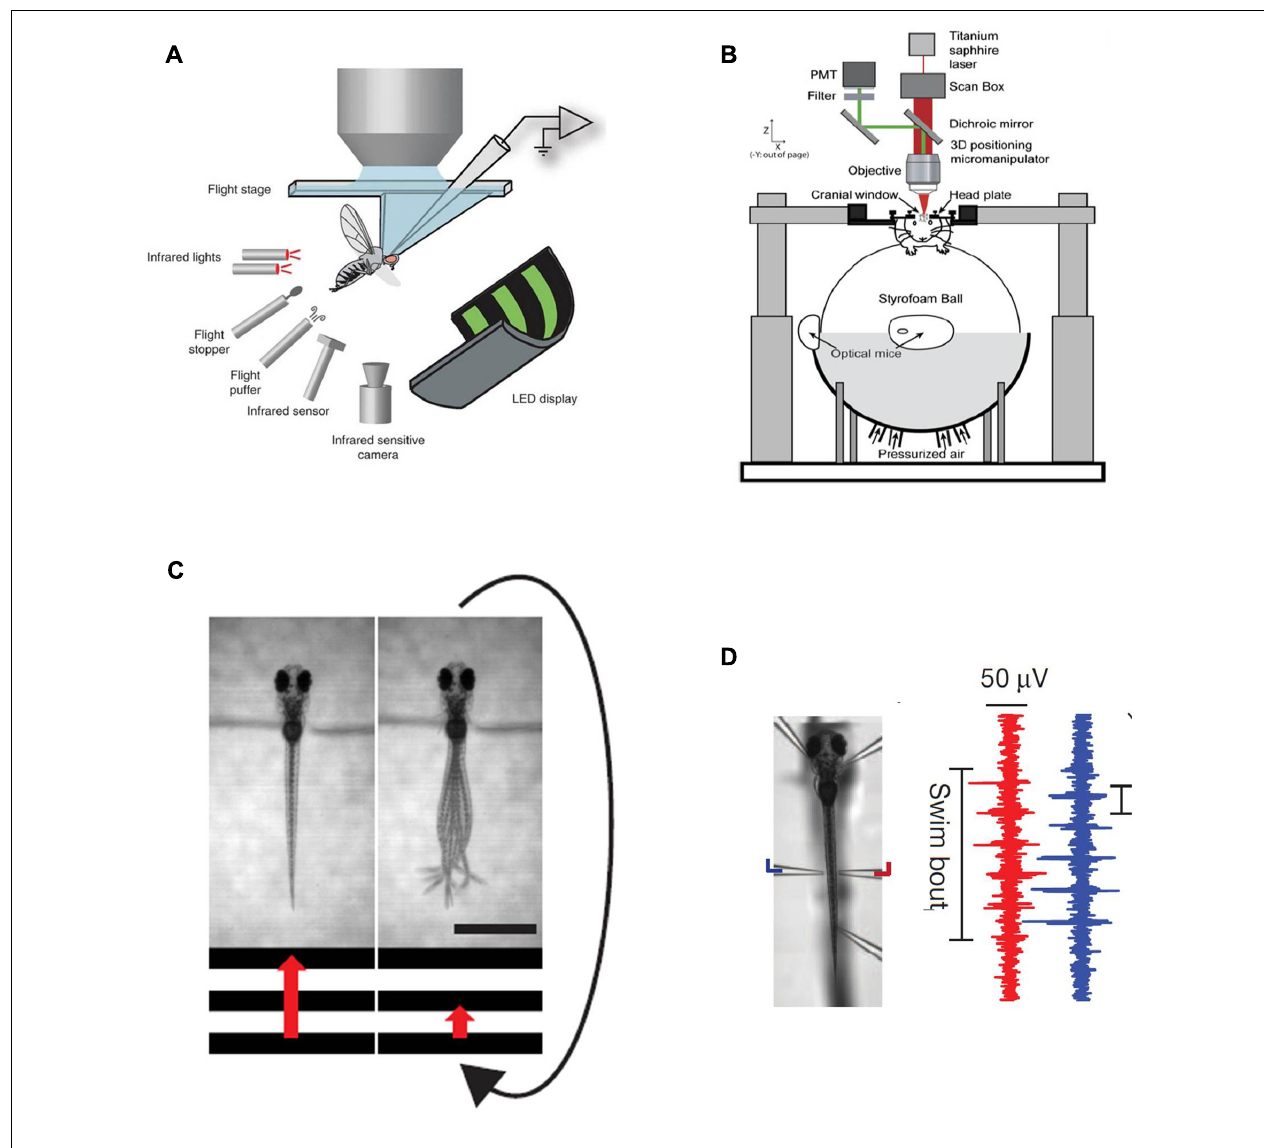
monitored with a high-speed camera.When the fish swims the stimulus slows down such that the relative motion between the larva and the moving grating resembles freely swimming conditions.The scale bar at the bottom right is 1 mm. (D) Left : Photomicrograph of a fish suspended in mid-water from five pipettes, two of which double as recording electrodes. Right : Example of a two-channel recording of a fictive swim.The left (blue) and right (red) signals are out of phase, as in earlier fictive swimming publications such as Masino and Fetcho